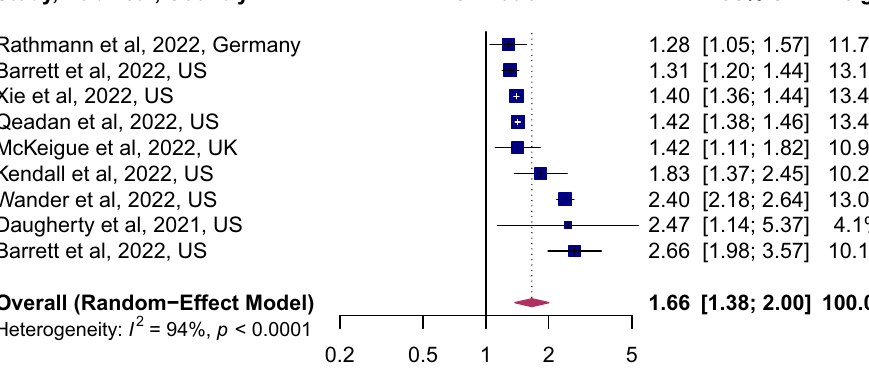
Figure 2. Forest plot for the overall pooled estimate for the association of COVID-19 and incident diabetes. Effect size values represent risk ratio and corresponding 95% CI. Blue squares and their corresponding lines are the point estimates of each study and 95% confidence intervals (95% CI). Maroon diamonds represent the pooled estimate (width denotes 95% CI). Heterogeneity ( I 2 = 94%, p for heterogeneity < 0.0001; 8 studies).